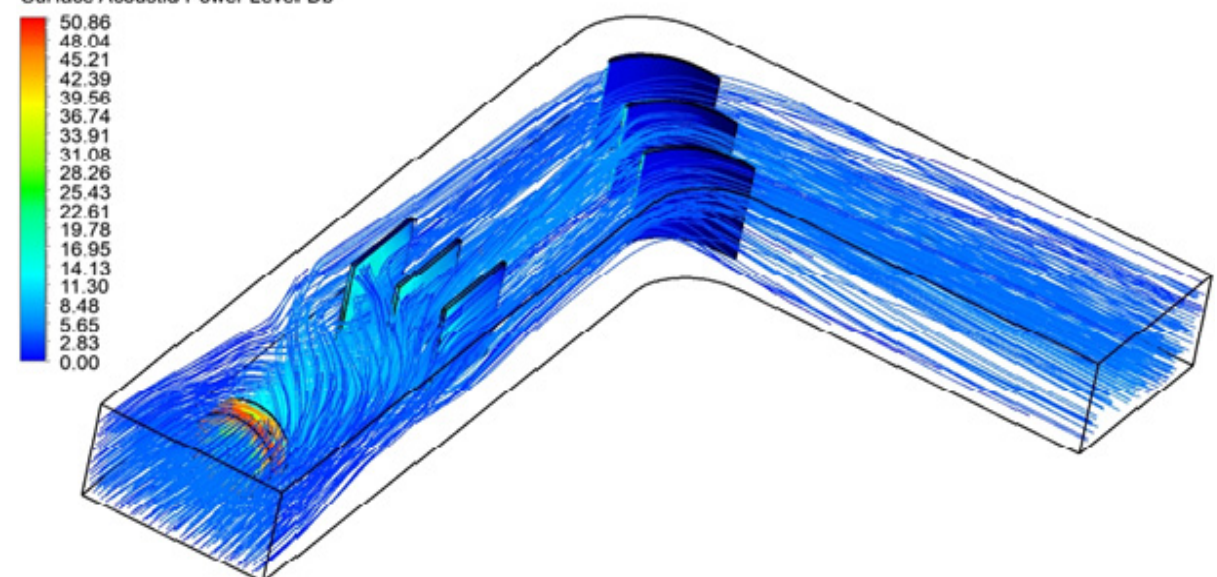
Figure 8. Surface acoustic power level and velocity fields in the air duct with 90 0 elbow with moderate radius and turning vanes in the shape of